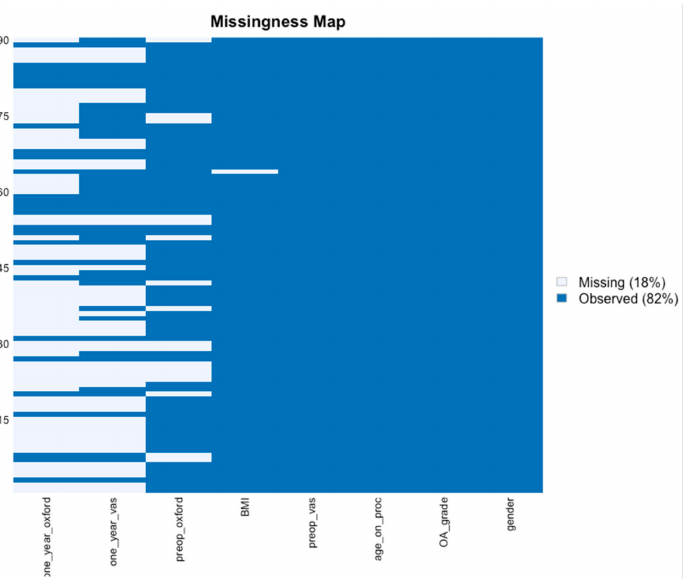
Figure 2. Missingness map MFAT + PRP data. Our dataset consisted of 90 sets of observations and 8 variables per set of observation, for a total of 720 data points. Missingness rate of 18% (light blue) due to patient lost-to-follow-up and 82% observed (blue). x -axis: outcome variables: Gender, Kellgren-Lawrence Osteoarthritis grade (OA Grade), age at the time of the procedure, Body Mass Index (BMI), Oxford Hip Score (OHS) for function, and Visual Analogue Scale (VAS) for pain at pre-operative baseline and one-year follow-up. y -axis: data points missing (18%) due to patients lost-to-follow-up. Source: authors’ data and reproducible statistical analysis with Open Access statistical software R (version 4.0.0 or